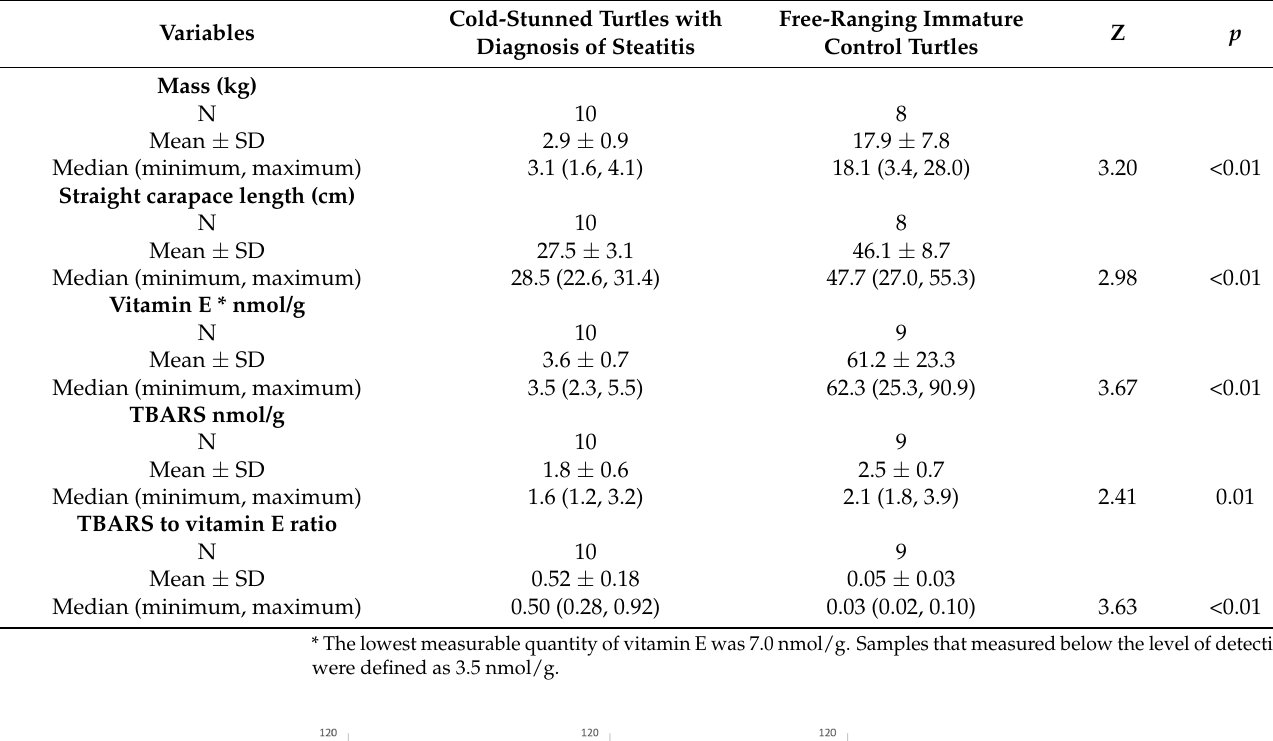
Table 3. Mass, straight carapace length, and plasma concentrations of α -tocopherol (vitamin E), thiobarbituric acid reactive substances (TBARS), and TBARS to vitamin E ratios of cold-stunned Kemp’s ridley sea turtles ( Lepidochelys kempii ) affected with steatitis compared to those of free-ranging immature control turtles.